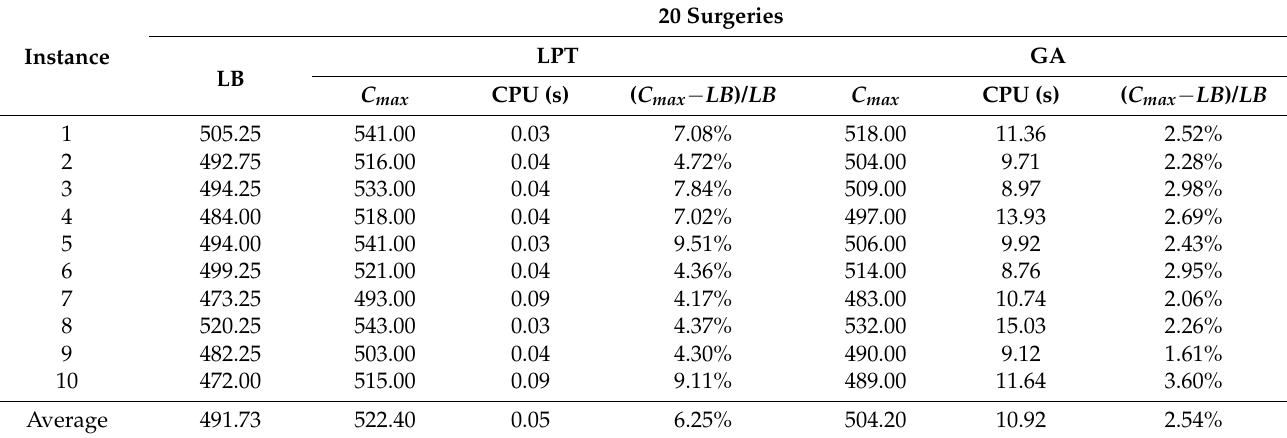
Table 7. Results of 20